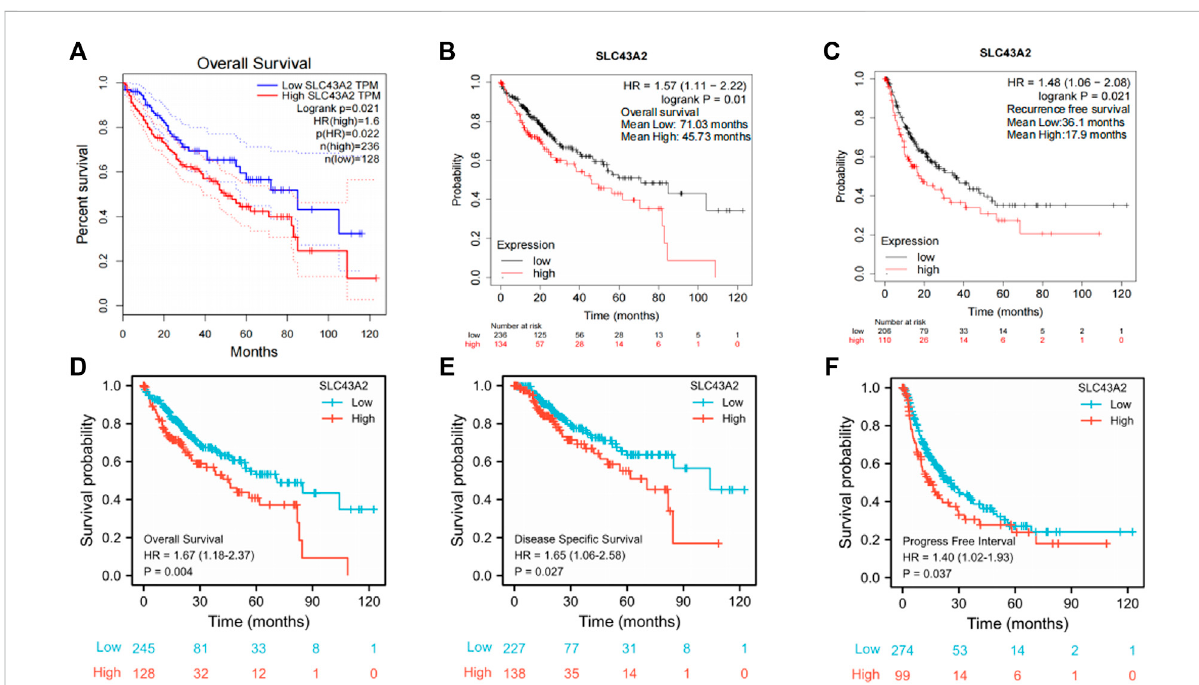
FIGURE 3 Correlations between SLC43A2 expression and survival in LIHC. OS curves in LIHC patients with SLC43A2-high or -low expression by using GEPIA [ (A) , logrank p = 0.021, HR = 1.6]. OS (B) and RFS (C) in LIHC patients with SLC43A2-high or -low expression by using the Kaplan Meier plotter database (logrank p = 0.01 and logrank p = 0.021, respectively). OS, DSS, and PFI between LIHC patients with high or low SLC43A2 expression in TCGA-LIHC cohort [ (D – F) , p = 0.004, 0.027, and 0.037 respectively]. OS, overall survival; DSS, disease-speci fi c survival; PFI, progression-free interval; RFS, recurrence-free